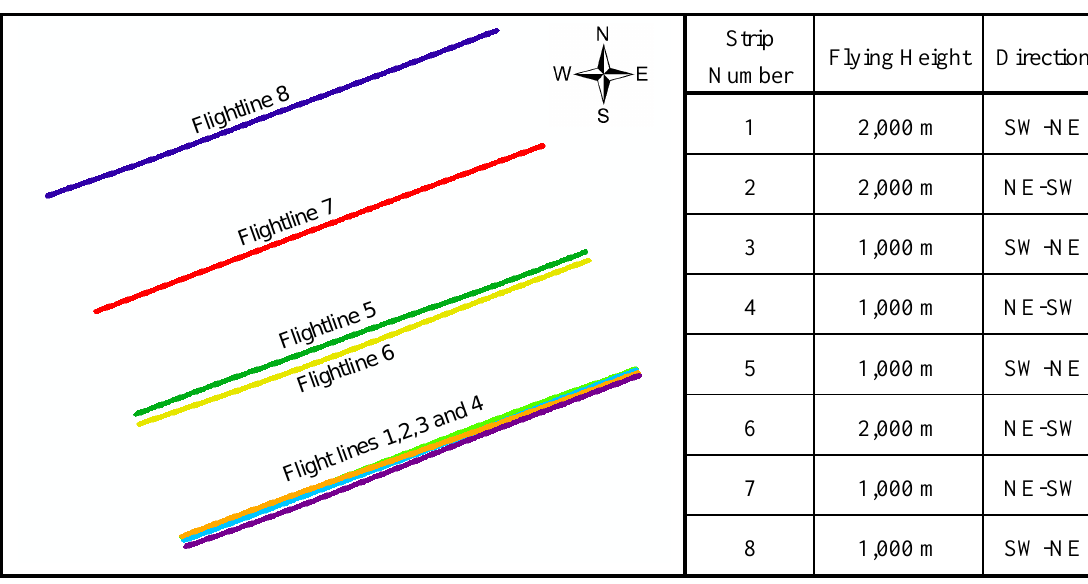
Figure 5. LiDAR dataset configuration.